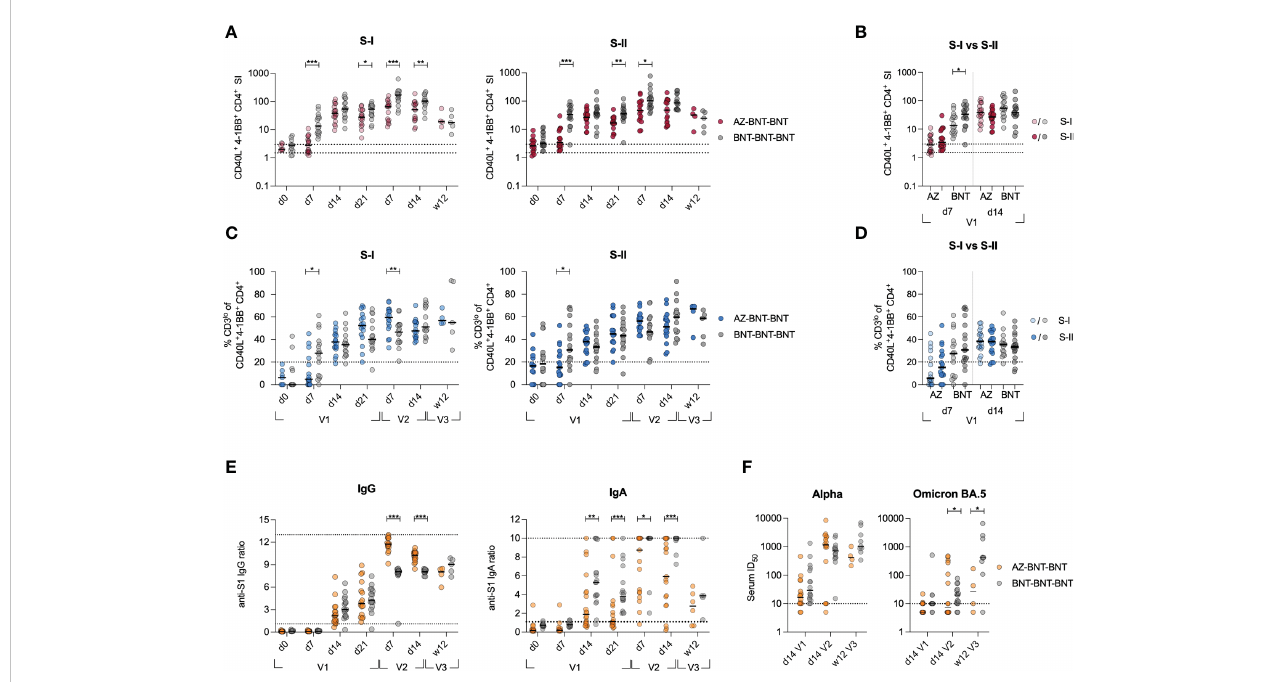
FIGURE 2 Heterologous vaccination results in slower induction of CD4+ T cell responses, but higher IgG responses compared to homologous vaccination. (A) Ex vivo stimulation of PBMCs from donors receiving heterologous AZ-BNT and homologous BNT-BNT vaccination with S-I and S-II peptide pools at indicated time points. SI of antigen-speci fi c CD40L+4-1BB+ CD4+ T cells is shown. (B) Ex vivo stimulation of PBMCs from AZ or BNT primary vaccinated donors with S-I and S-II peptide pools early and at peak of immune response. SI of antigen-speci fi c CD40L+4-1BB+ CD4+ T cells is shown. (C) Frequencies of CD3lo cells among S-I- or S-II-reactive CD40L+4-1BB+ CD4+ T cells of T cell responses with a SI ≥ 1.5. (D) Ex vivo stimulation of PBMCs from AZ or BNT primary vaccinated donors with S-I and S-II peptide pools early and at peak of immune response. Frequencies of CD3lo antigen-speci fi c CD40L+4-1BB+ CD4+ T cells are shown. (E) Serum anti-SARS-CoV-2 S-1 IgG and IgA antibody levels (OD) were determined at indicated time points. Upper and lower levels of detection were set at 1 and 13 (IgG)/ 10 (IgA), respectively, indicated by dotted lines. (F) Anti-SARS-CoV-2 B.1.1.7 (Alpha) and B1.1.529 (Omicron) subtype BA.5 variant spike neutralizing capacity at d14 post primary, d14 post secondary and 12 weeks post booster vaccination. Positivity thresholds: >10 ID50 for spike neutralization. Serum ID50 values less than the lowest serum dilution tested (1:10) were assigned a value of 5 for plotting the graph and for statistical analysis. Only signi fi cant differences are shown with *P < 0.05, **P < 0.01, ***P < 0.001, Mann-Whitney test. SI below 1 were excluded from further analysis, as they are below the lower limit of detection. Black line indicates the